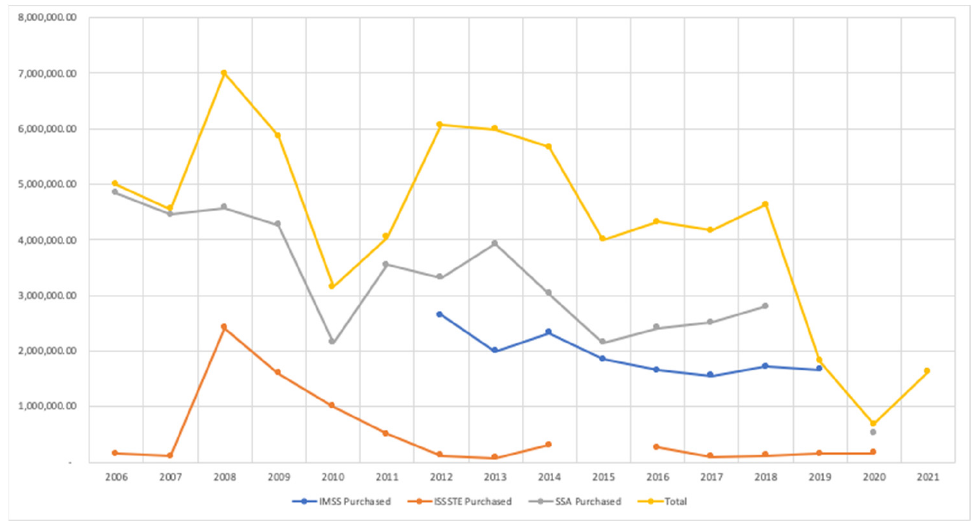
Figure 1. BCG vaccines. Annual acquisition.